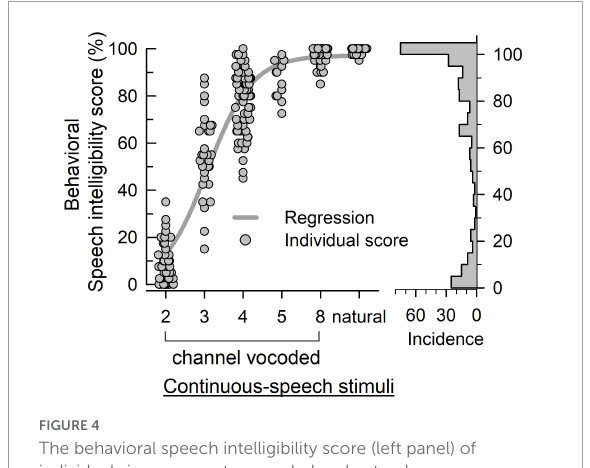
FIGURE4 The behavioral speech intelligibility score (left panel) of individuals in response to vocoded and natural continuous-speech stimuli. The bars (right panel) indicate the incidence of each